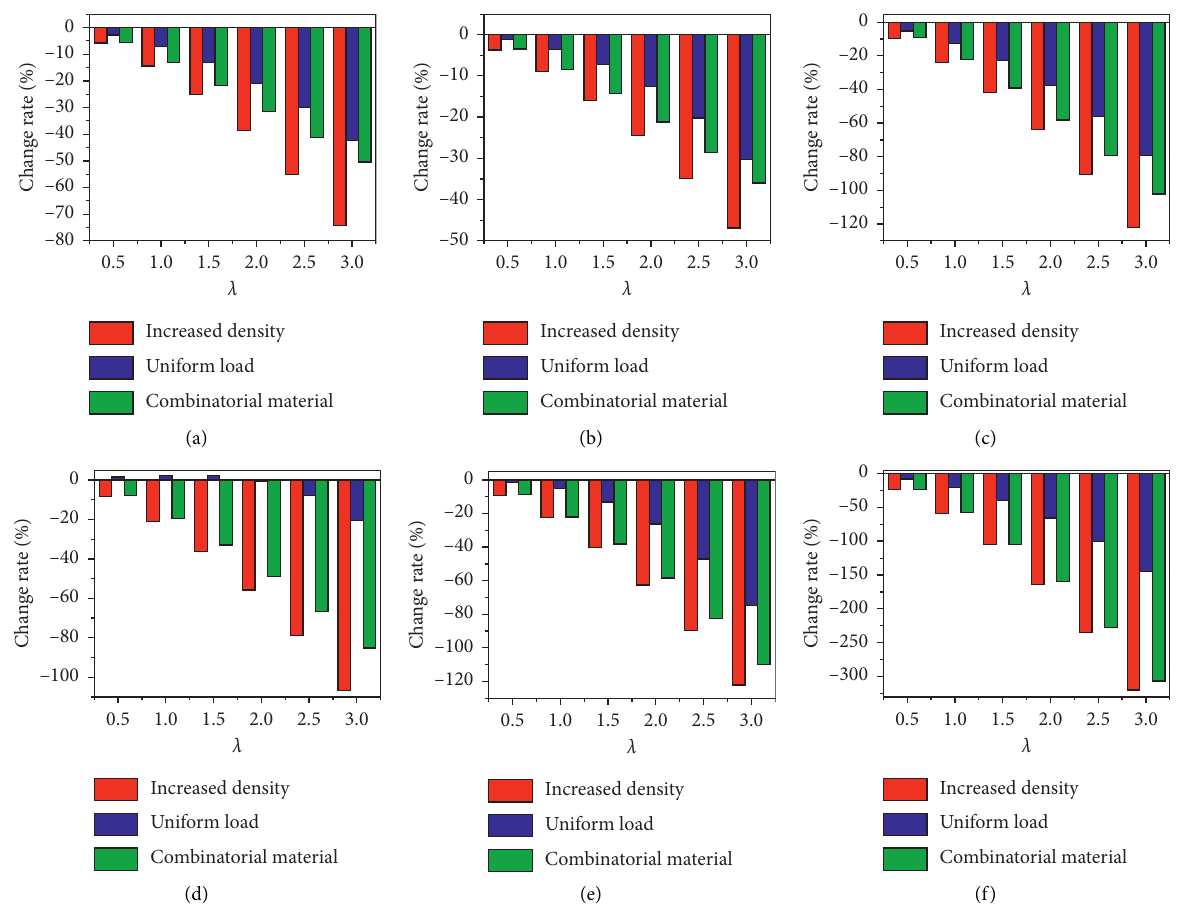
Figure 15: Comparison of statistical minimum of contact force calculated by three different methods: (a) v � 150km/h; (b) v � 200 km/h; (c) v � 250km/h; (d) v � 300km/h; (e) v � 350km/h; (f). v �